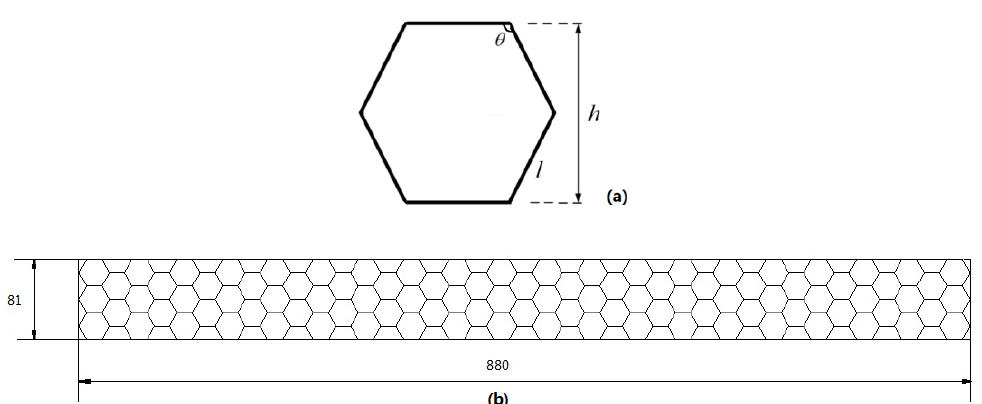
Figure 4. Cell configuration and design of the honeycomb sandwich blast wall (HSBW). ( a ) honeycomb unit cell, ( b ) honeycomb layout.